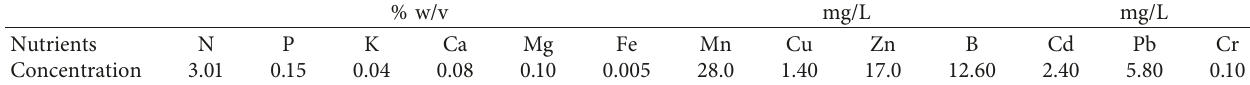
Table 2: Chemical properties of boron-based liquid fertilizer.